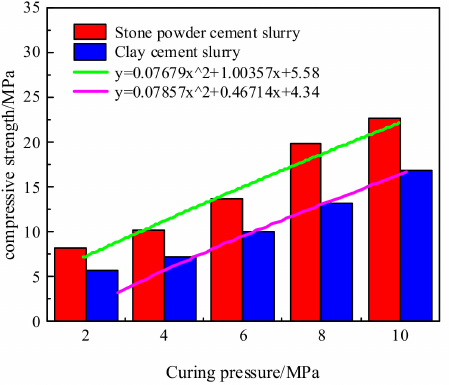
Figure 13. Relations between curing pressure and compressive